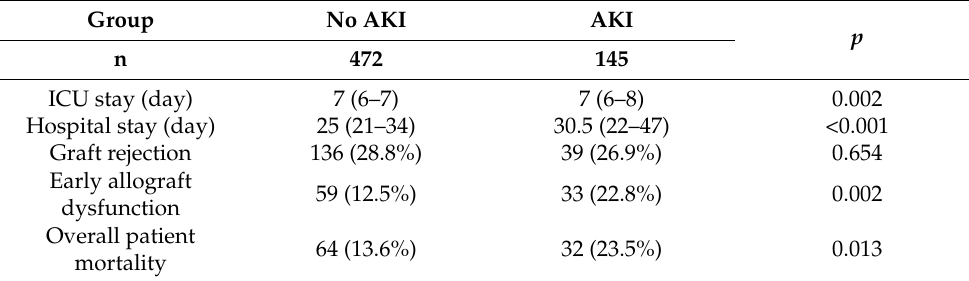
Table 6. Comparison of postoperative outcomes between the non-AKI and AKI